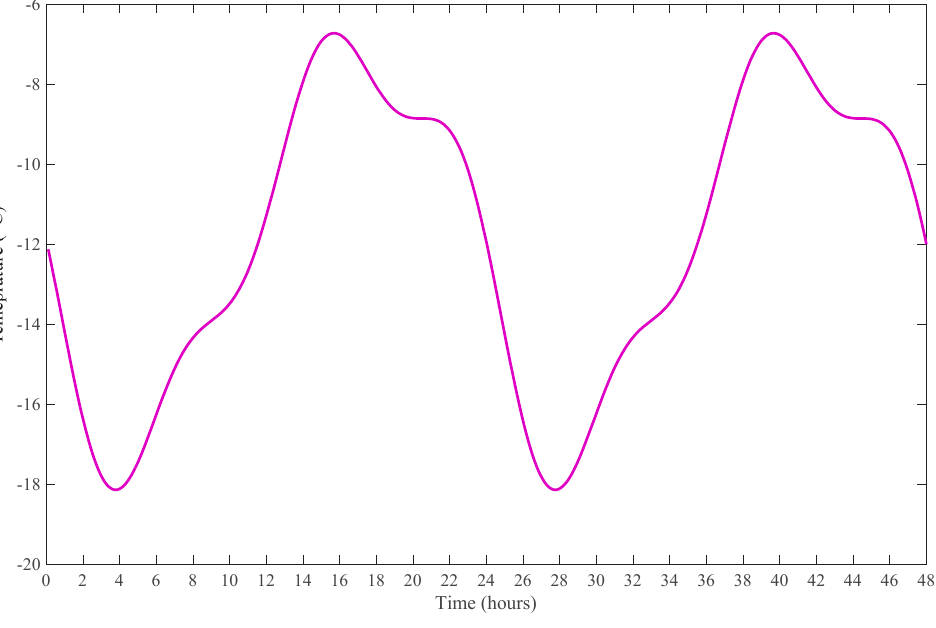
Figure 6. Ambient temperature profile.